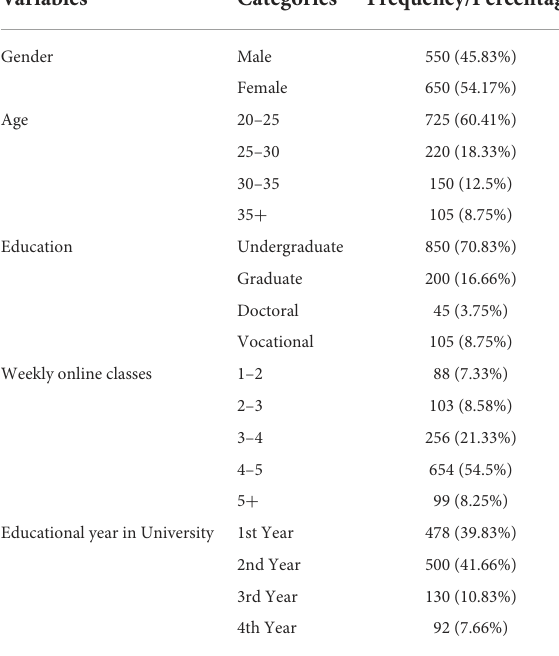
TABLE 1 Demographic information of study participants (N-1200). TABLE 2 Results of the measurement model of research